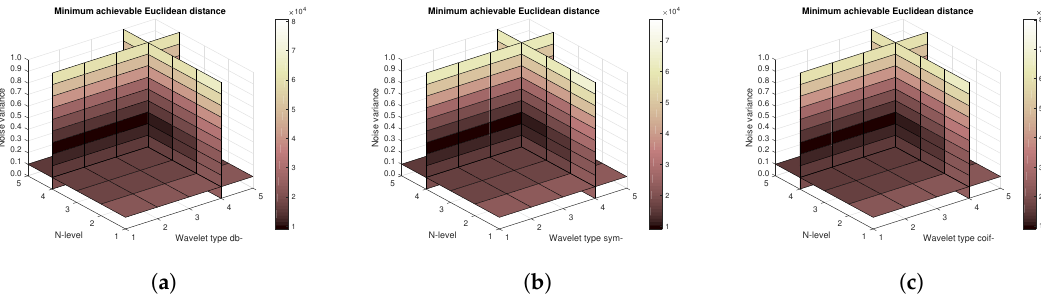
Figure 22. Euclidean distance in the presence of Salt and Pepper noise only for the CT scan from Figure 4 with use of three mother wavelet families—from left Daubechies ( a ), Symlet ( b ) and Coiflet ( c ).